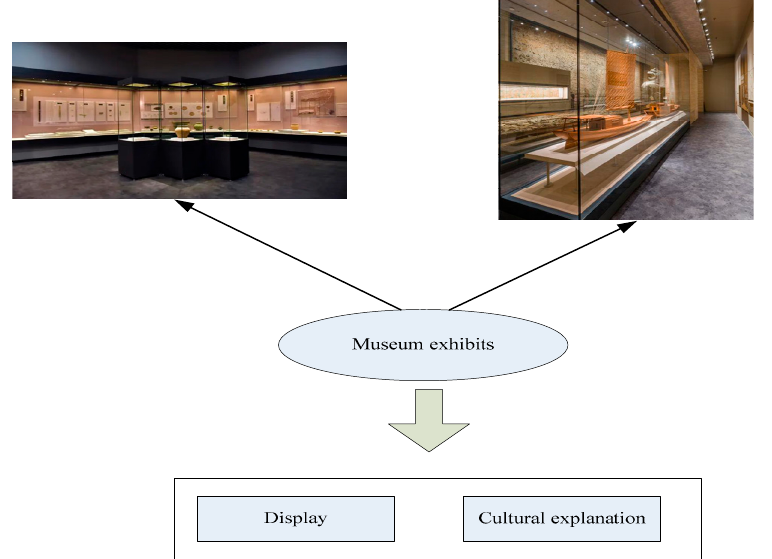
Figure 1. Traditional museum visiting mode.